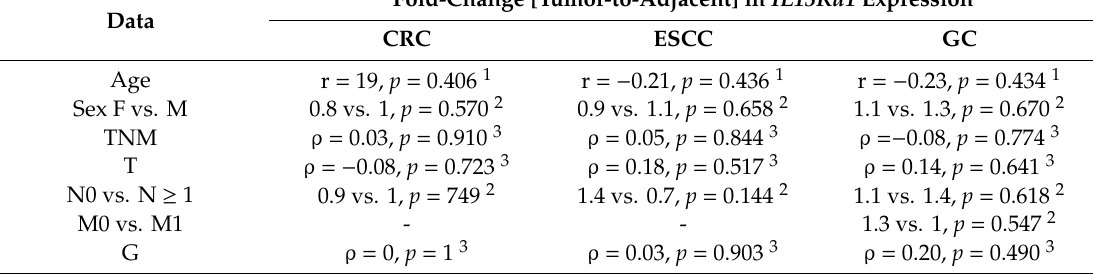
Table 8. Association of demographic and pathological data with IL13Ra1 expression in the GIT cancer